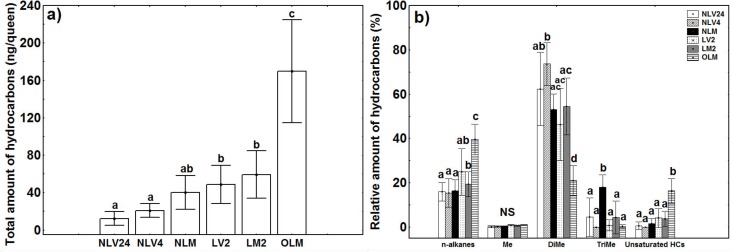
Total absolute amount of hydrocarbons (a) and relative amount of hydrocarbons (b) in invasive queens according to reproductive status (mean ± SD) (n = 76). The abbreviations for reproductive status are as in Fig 1. The following additional abbreviations were used in (b): mono-methyl alkanes (Me), di-methyl alkanes (DiMe), and tri-methyl alkanes (TriMe).